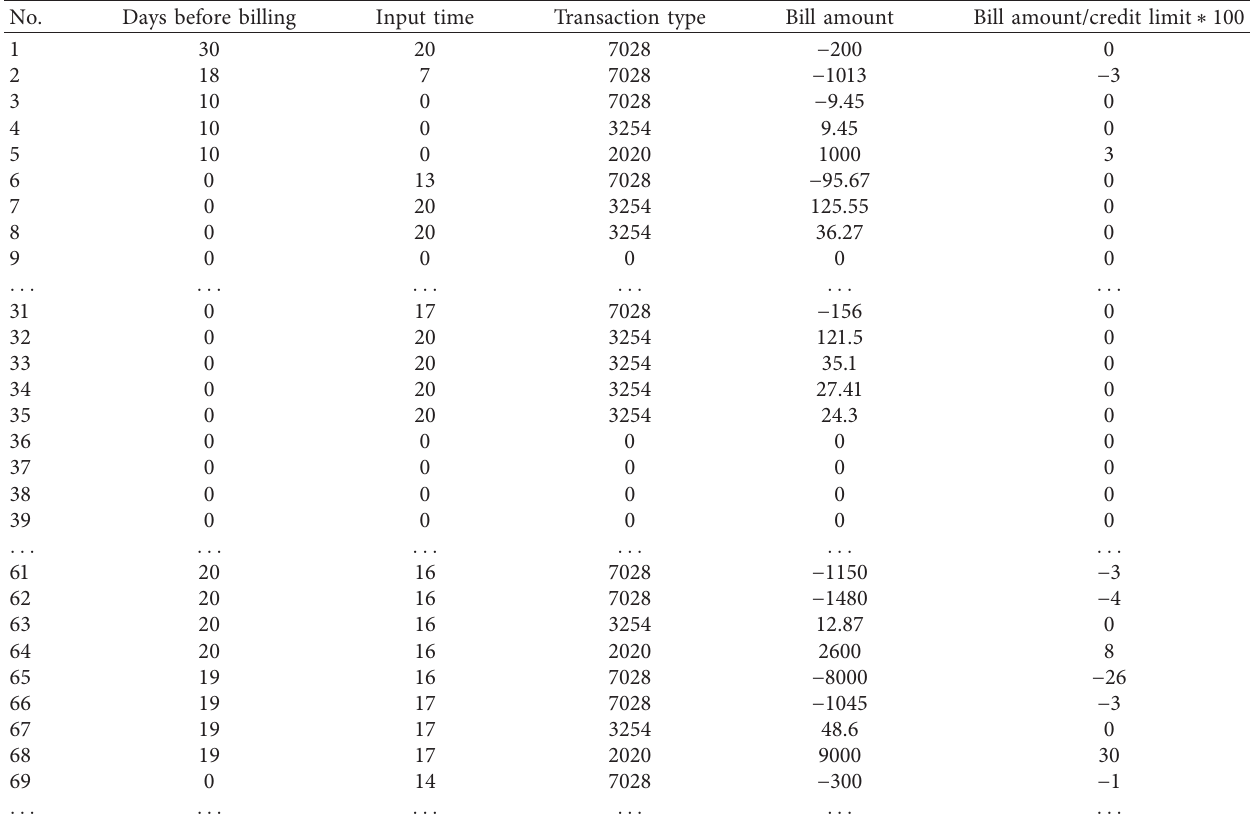
Table 6: Example of LSTM model input data